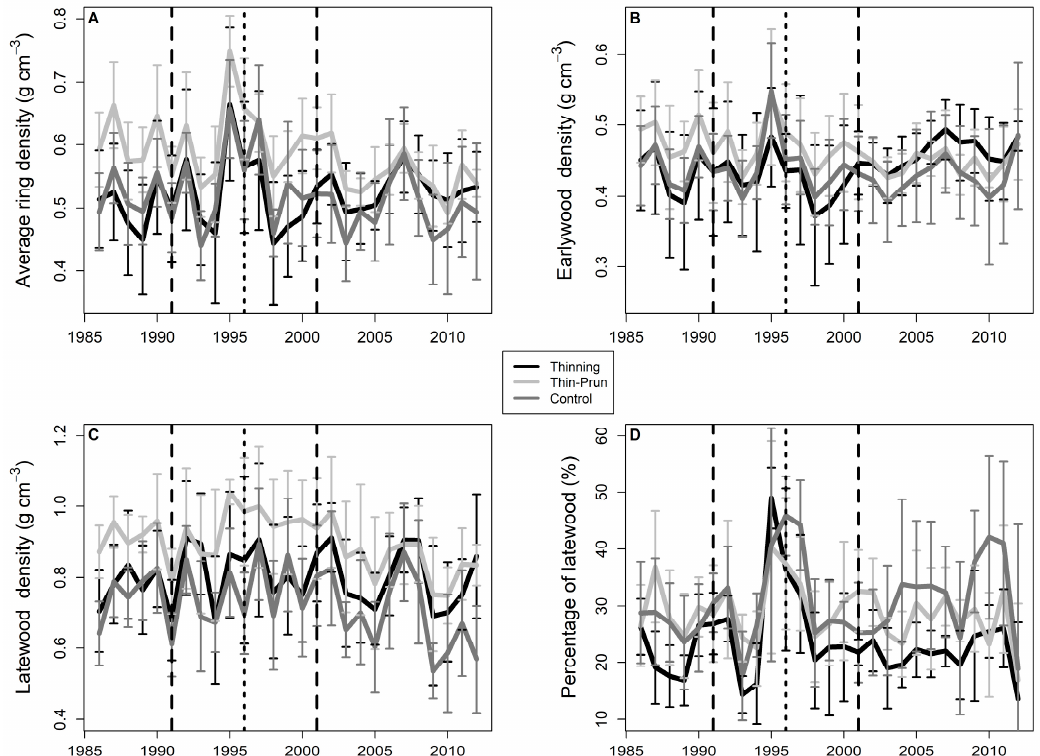
Figure 1. Mean trends ± standard deviation of average ring density ( A ), earlywood density ( B ), latewood density ( C ), and percentage of latewood ( D ) for the treatments in Pinus sylvestris trial. Vertical dashed lines indicate thinning treatment dates (1991 and 2001) and dotted line indicates the snow-throws (1996).